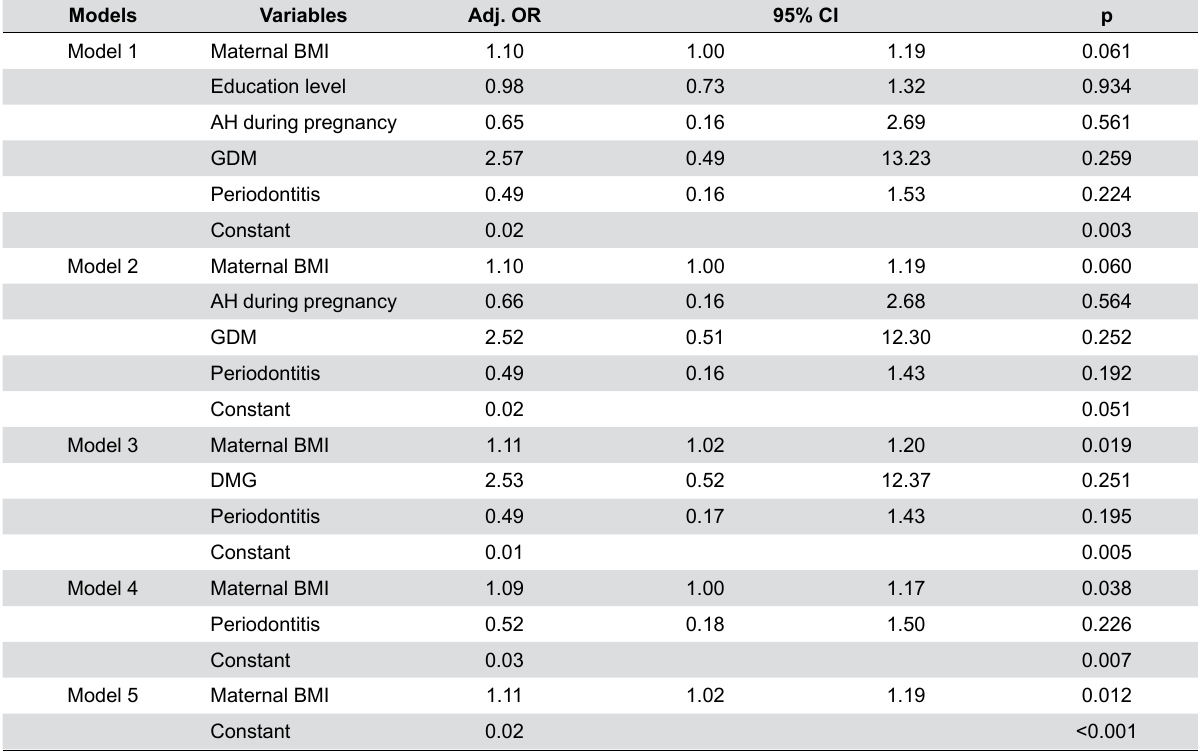
Table 3- Binary logistic regression model showing the independent variables associated with low/insufficient infants’ weight at Models